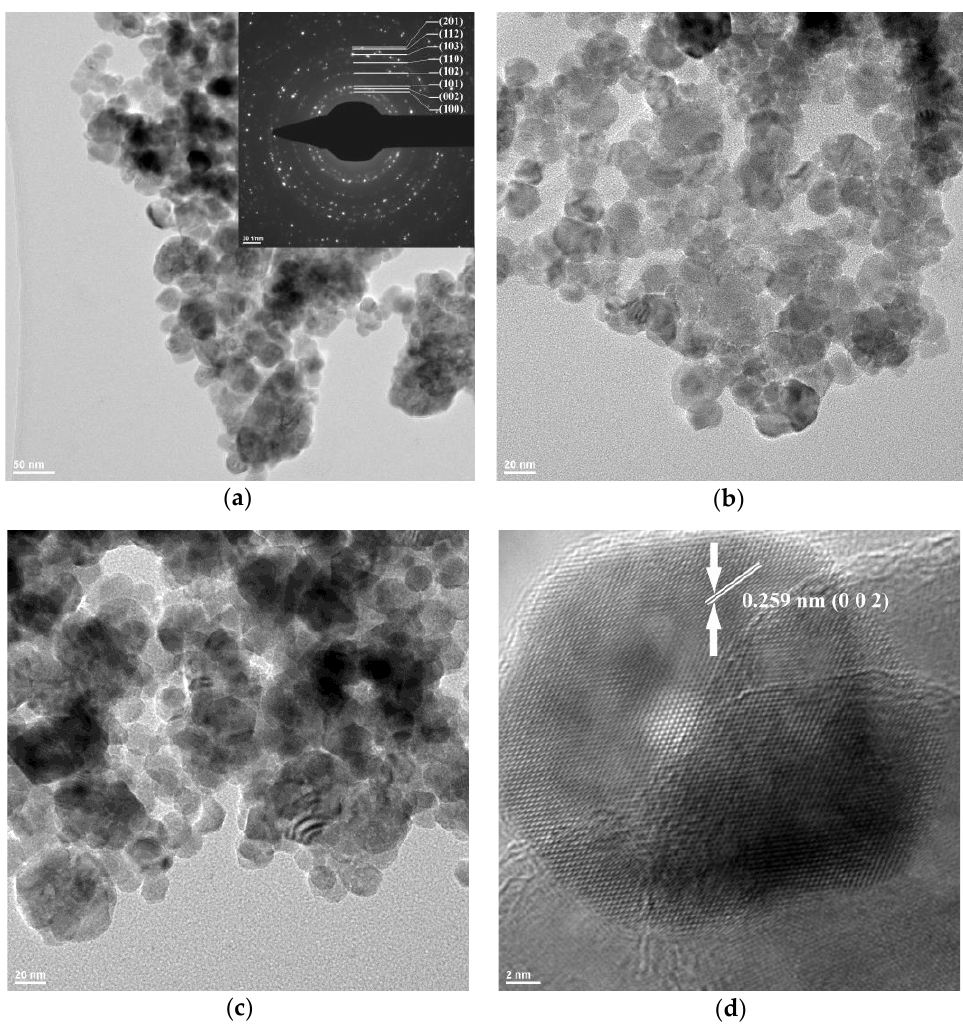
Figure 3. The TEM images for ZnO_B sample ( a ) 39,000× magnification and SAED pattern of hexagonal ZnO (JCPDS card no. 80-0075) in inset; ( b , c ) 75,000× magnification; ( d ) high resolution TEM with (0 0 2) crystallographic planes.